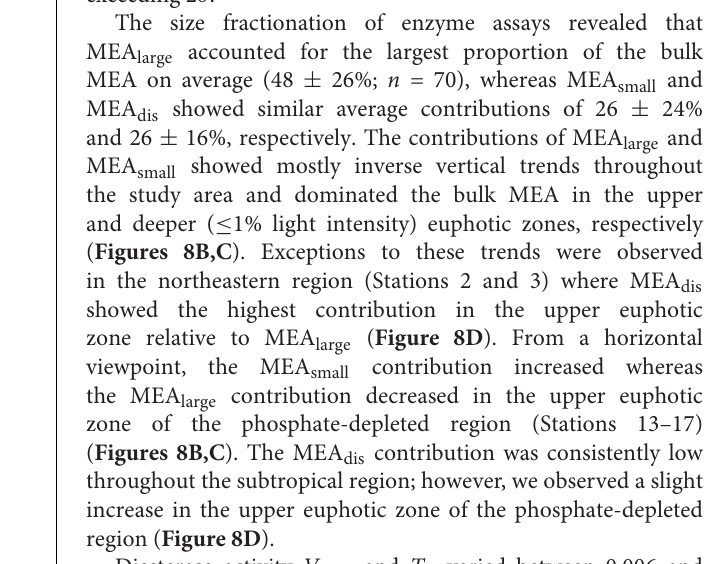
the phosphate-depleted region (Stations 13–17). In